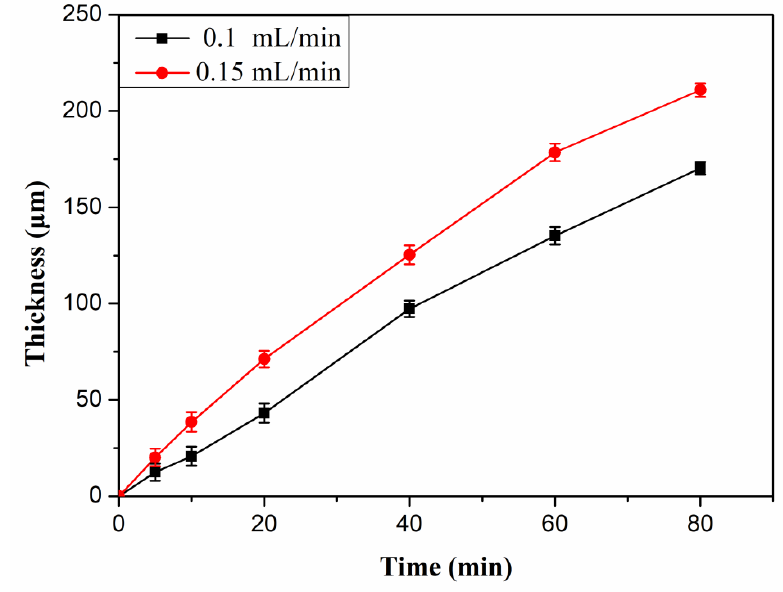
Figure 3. The thickness-time relationship at spraying rates of 0.1 and 0.15 mL/min.